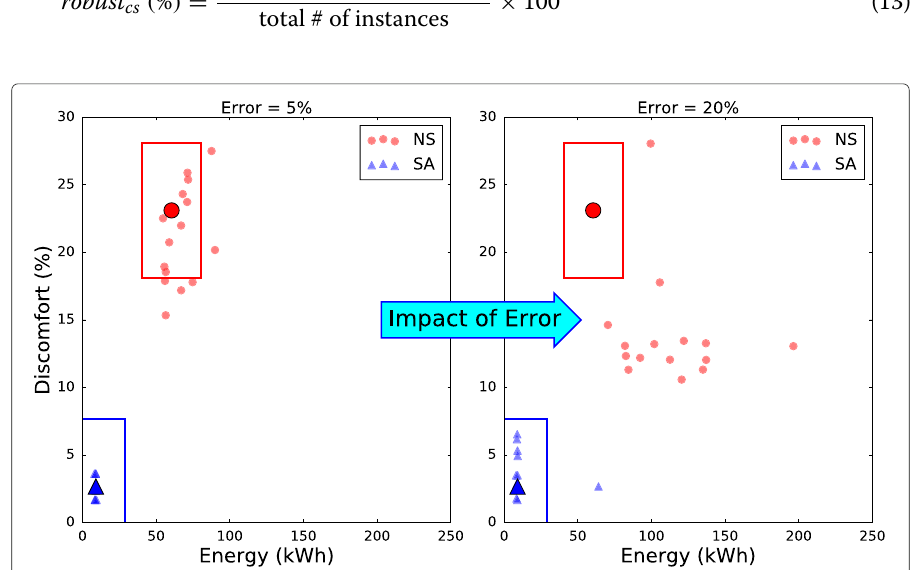
Fig. 5 Illustration. As error increases, the energy consumption and occupants’ discomfort vary depending on the nature and the timing of prediction errors. 5% errors on the left and 20% on the right. Large circles/triangles indicate a perfect prediction scenario and small circles/triangles correspond to those scenarios when occupancy prediction was